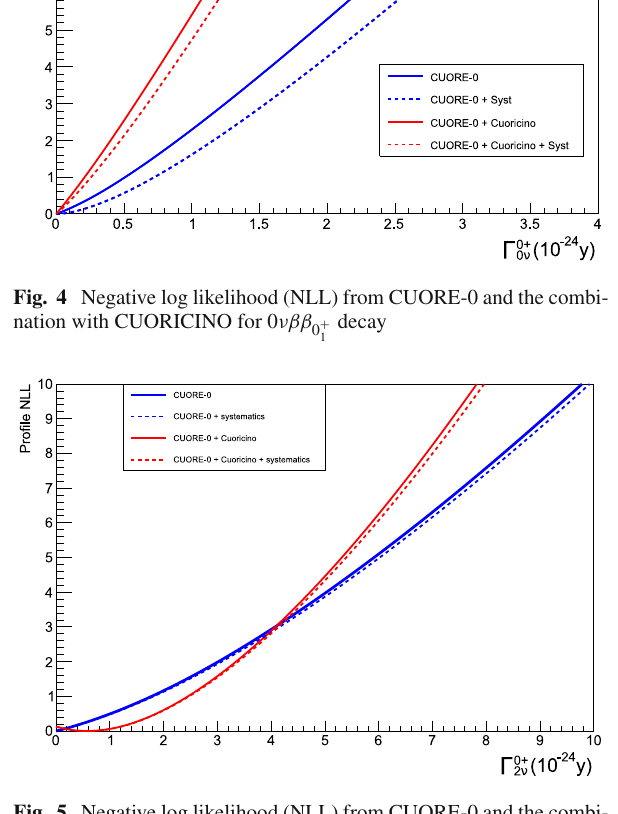
Fig. 5 Negative log likelihood (NLL) from CUORE-0 and the combi- nation with CUORICINO for 2 νββ 0 + 1